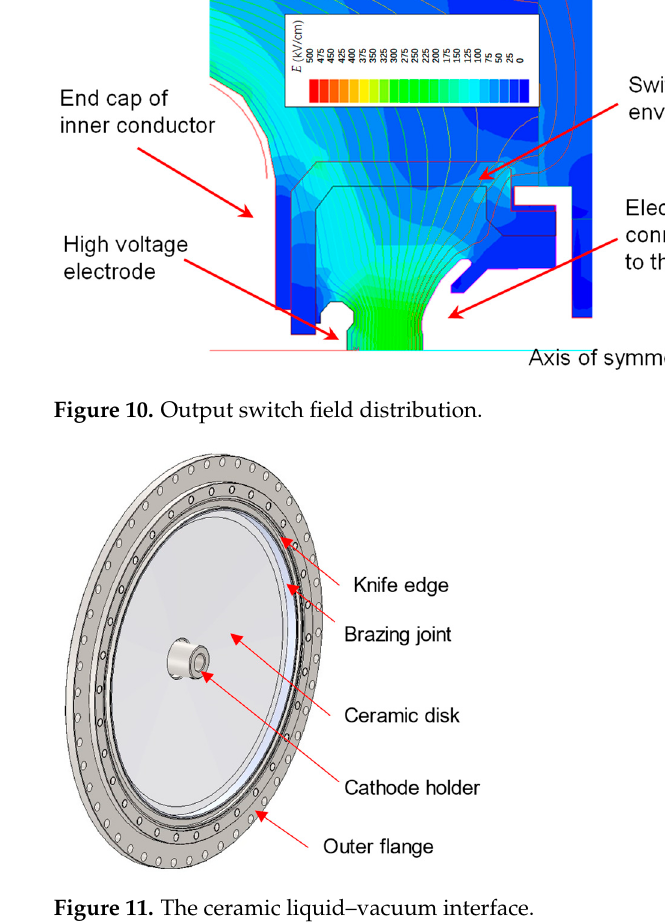
Figure 11. The ceramic liquid–vacuum interface.